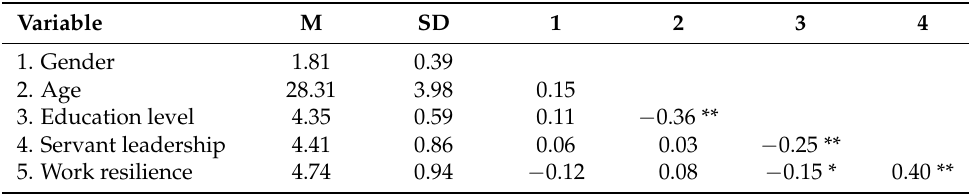
Table 1. Means, standard deviations, and correlations.